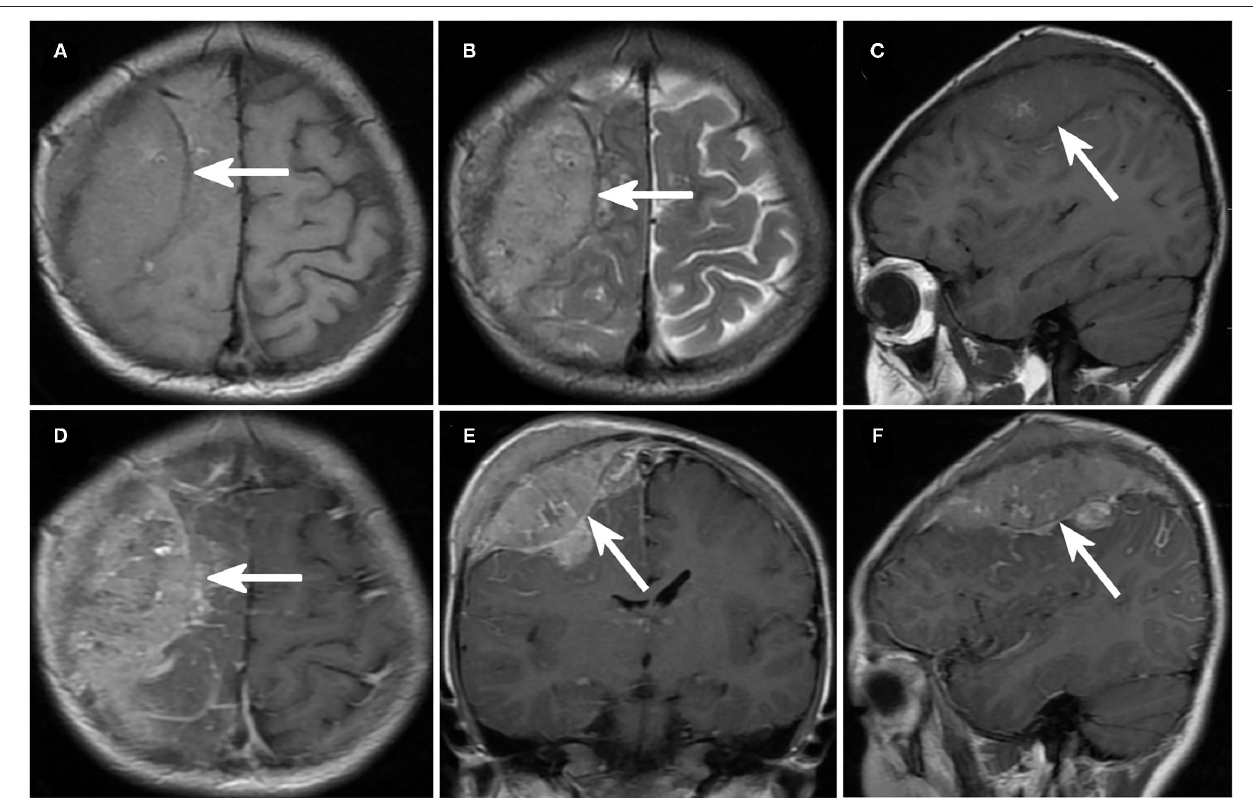
FIGURE 1 | Imaging of neuroblastoma with intracranial metastases. (A–C) Axial (A,B) and sagittal (C) magnetic resonance imaging (MRI) in case No. 11 demonstrated a recurrent mass lesion in the right occipital lobe. (D–F) Cranial enhanced MRI of case No. 11, axial (C) , coronal ( D) , and sagittal (F) images.